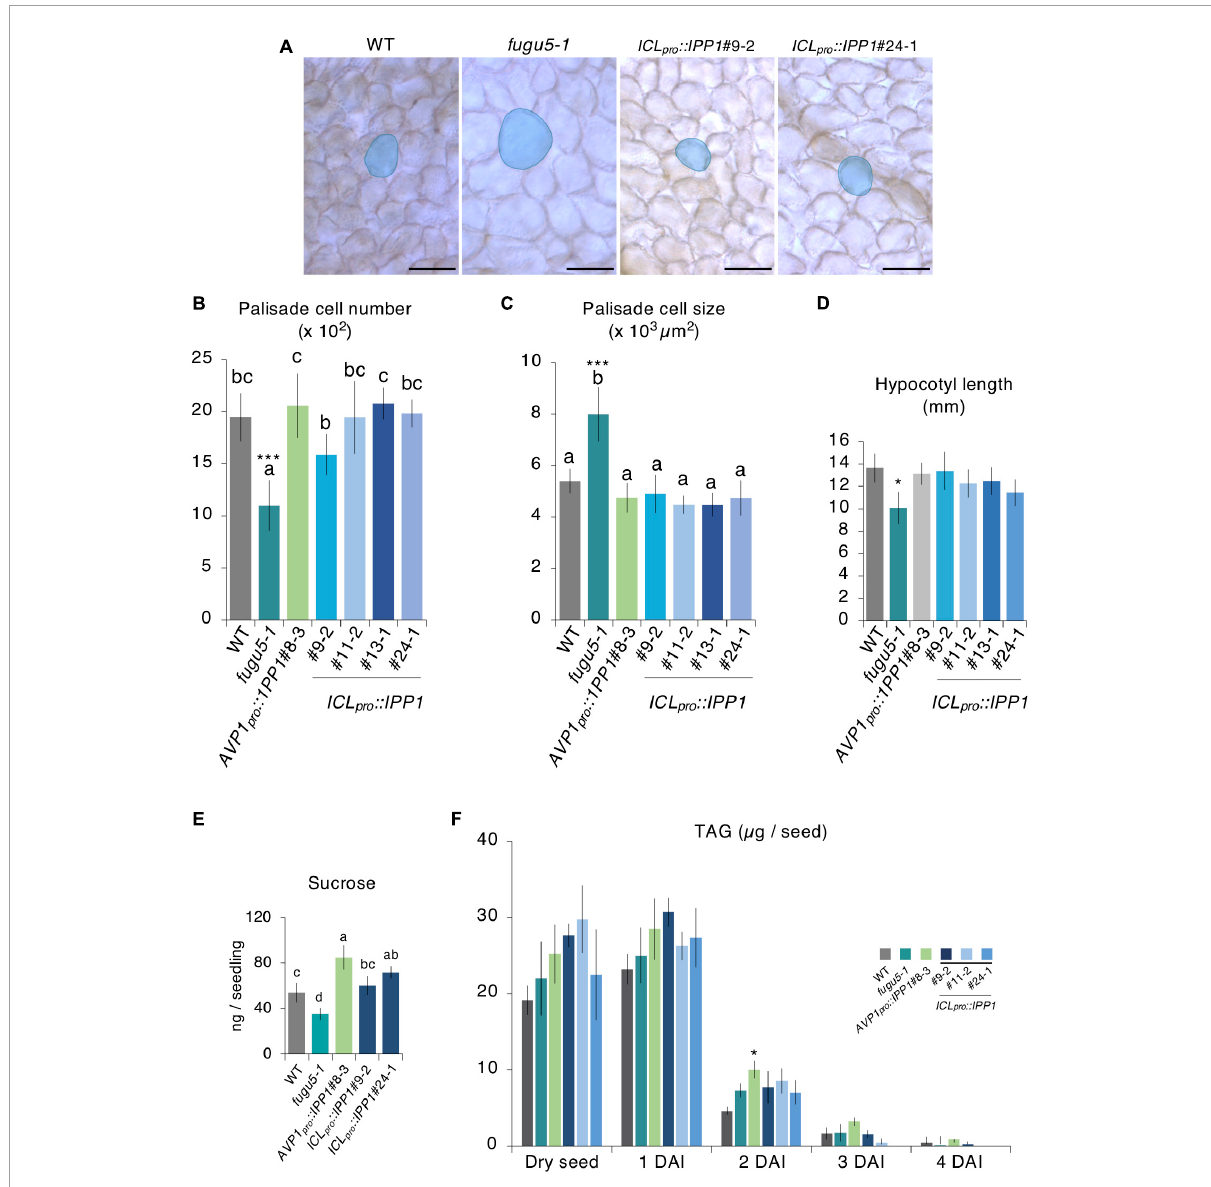
FIGURE5 Effect of developmental stage-specific removal of inorganic pyrophosphate (PPi) on cotyledon cellular phenotype and etiolated seedling elongation. (A) Micrographs of cleared cotyledon palisade tissue cells from the wildtype (WT), fugu5-1 , ICL pro ::IPP1 #9-2, and ICL pro ::IPP1 #24-1 at 25 DAS. Blue contour and shadow highlight representative cell size in each genotype. Scale bar = 100 µ m. (B) Numbers and (C) sizes of cotyledon subepidermal palisade tissue cells; means ± SD ( n = 6 cotyledons). Each character represents a significant difference at p < 0.05. ***Significant difference at p < 0.0001 compared to the WT (Tukey’s HSD test). (D) Hypocotyl length at 4 DAI; means ± SD ( n = 21 seedlings). *Significant difference at p < 0.01 compared to the WT (Tukey’s HSD test). (E) Sucrose levels of 100 etiolated seedlings at 3 DAI by GC-MS/MS. Data are means ± SD ( n = 4 independent experiments). Each character represents a significant difference at p < 0.05 (Tukey’s HSD test). (F) Time course of the mobilization of triacylglycerol (TAG) during post-germinative growth. The TAG content was quantified with 20 dry seeds or 20 etiolated seedlings at 1, 2, 3, and 4 DAI. Data are means ± SD ( n = 3 independent experiments). *Significant difference at p < 0.05 compared to the WT. DAS, days after seed sowing, DAI, days after induction of seed